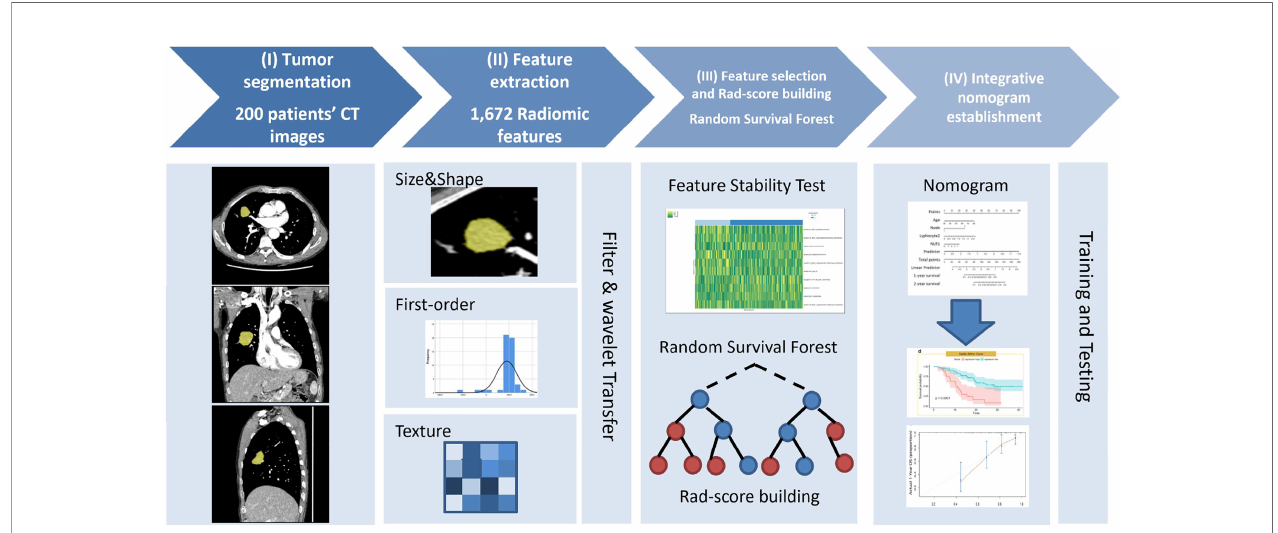
FIGURE 2 | Study work fl ow diagram. (I) Tumor segmentation: 3D semi-automatic segmentation of tumors on chest CT images. (II) Feature extraction: 1,672 radiomic features were automatically extracted from the segmented tumor volume. (III) Feature selection and Rad-score calculation: Spearman ’ s rank correlation was used to select reproductive and stable radiomic features, and random survival forest model was implemented to calculate Rad-score. (IV) Nomogram development: the model was trained and tested to determine its predictive